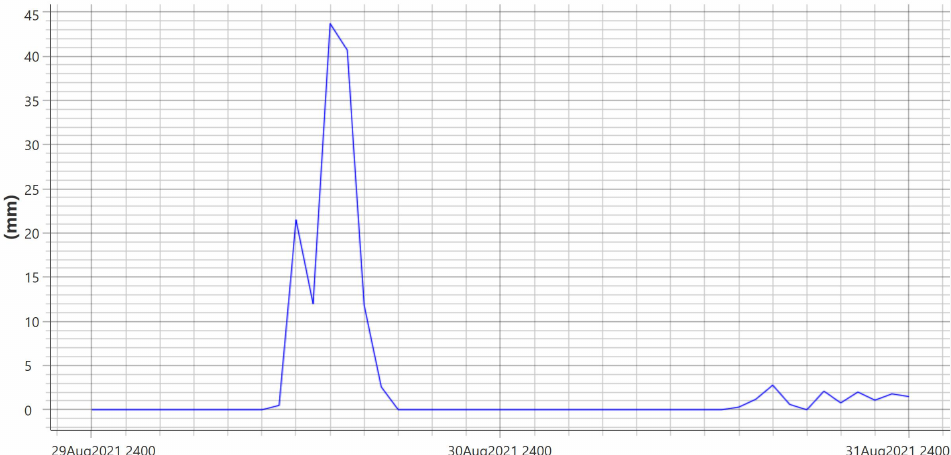
Figure 8. Multi-sensor Quantitative precipitation estimation data for one portion of Guesses Fork Road. The line shows hourly precipitation accumulations for a 48 h time